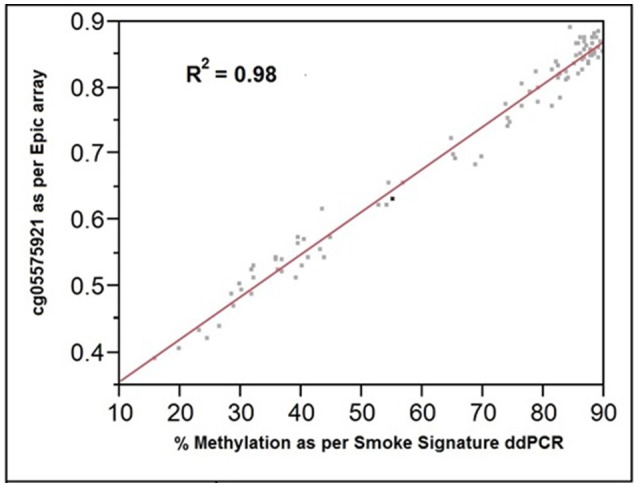
The relationship of cg05575921 methylation as assessed by the Illumina Epic array (expressed as fractional methylation) and the Smoke Signature ddPCR assay (expressed as % methylation). R2 = 0.98, n = 92.